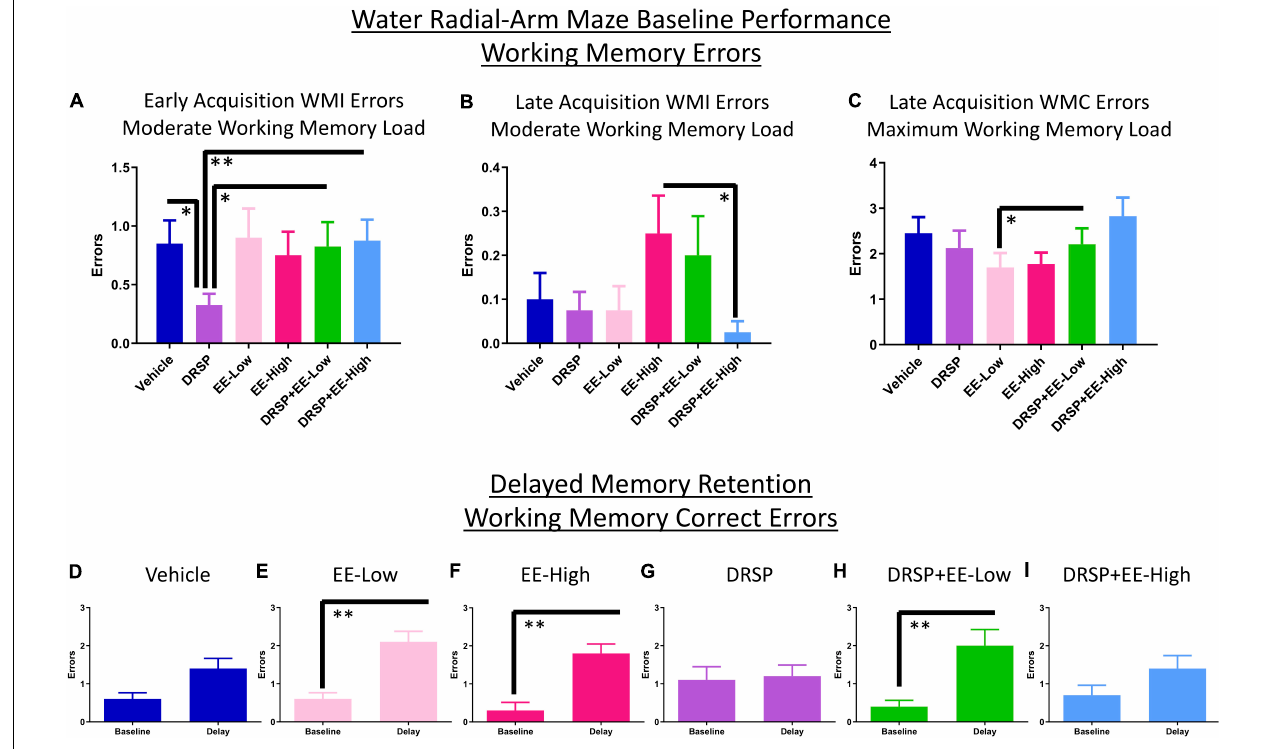
FIGURE 4 | Experiment 2 Water radial-arm maze. (A) During early acquisition, rats treated with drospirenone only showed enhanced WMI performance on the moderate working memory load trial compared to rats without hormone treatment, or rats given a combination of drospirenone plus a low or high dose of EE. (B) During the Late Acquisition Phase, rats treated with a combination of drospirenone and high EE had enhanced WMI performance on the moderate working memory load trial compared to rats treated with a high dose of EE only. (C) Rats treated with a combination of drospirenone and low EE showed impaired performance on the maximum working memory load trial compared to a low dose of EE alone during Late Acquisition. (D) Rats without hormone treatment did not exhibit a delay-induced memory impairment, (E,F,H) while rats treated with EE-Low, EE-High, and DRSP + EE-Low were significantly impaired following a 6-h delay. (G,I) The DRSP group and the DRSP + EE-High group were not significantly impaired following a 6-h delay. ∗ p < 0.05 and ∗∗ p < 0.01. Vehicle n = 10, DRSP n = 10, EE-Low n = 10, EE-High n = 10, DRSP + EE-Low n = 10, and DRSP + EE-High n =